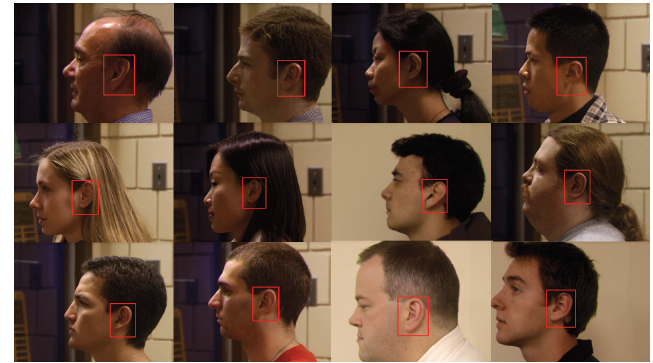
Figure 7. Ear detection and segmentation.